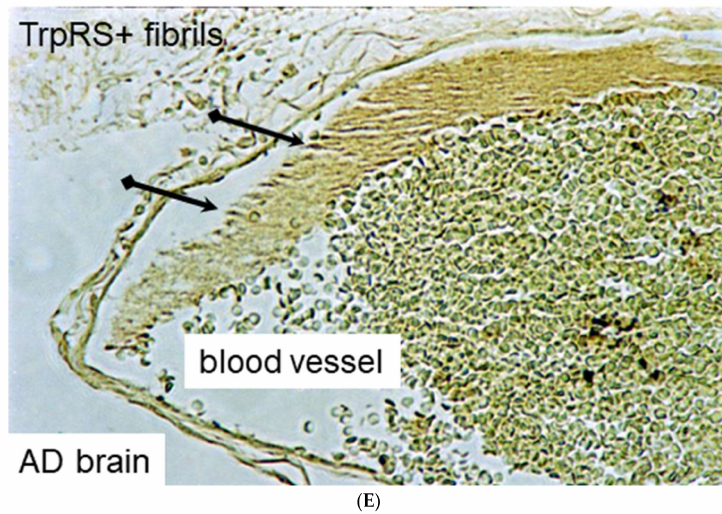
Figure 2. TrpRS is associated with AD vasculopathies. ( A ) The images demonstrate a partial co-localization of TrpRS (left panel) and A β (right panel) in the serial sections immunostained with anti-TrpRS antibodies (Ab) or Ab to A β . The clot-like TrpRS deposition is visible inside the vessel. The A β deposition is visualized in a neighboring section; ( B ) The blood vessels in the serial sections stained with Congo red/hematoxylin (right panel) or anti-TrpRS Ab (left panel); ( C ) Immunostaining of TrpRS in the blood vessel endothelial cells of AD hippocampus with mAb 6C10; ( D ) Immunostaining of TrpRS in the blood vessel endothelial cells of acute myocardial infarction hippocampus with mAb 6C10; ( E ) Microscopy of AD cerebral blood vessel immunostained with anti-TrpRS Ab. Arrows show the TrpRS immunostaining associated with fibrils inside the blood